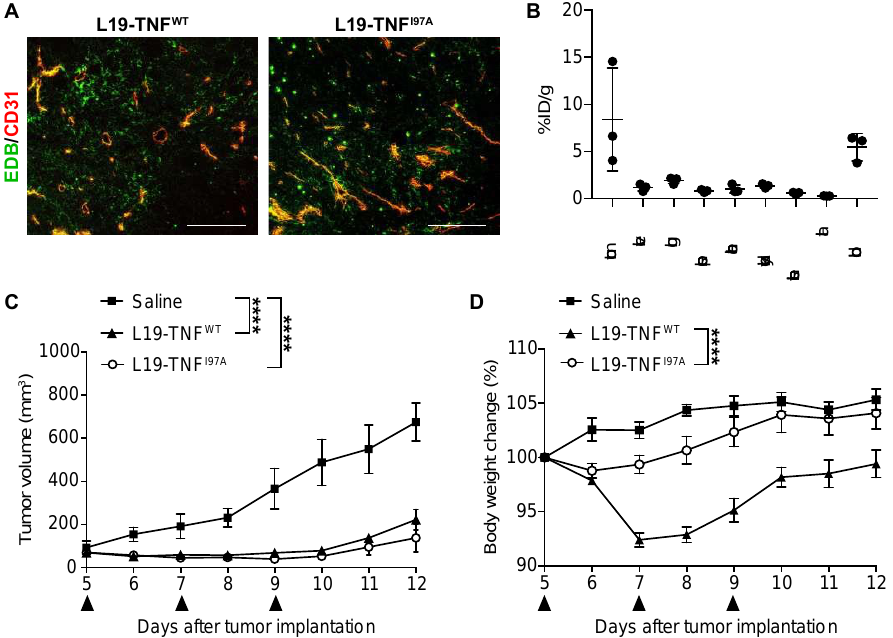
Figure 5. Tumor-targeting performance of L19-TNF I97A and in vivo therapy study in tumor-bearing mice. ( A ) Immunofluorescence staining of WEHI-164 tumors with L19-TNF I97A (L19-TNF WT was used as the positive control of the experiment). Green = L19-TNF WT or L19-TNF I97A , Red = CD31. Scale bar = 100 µm. ( B ) In vivo biodistribution with radioiodinated L19-TNF I97A in BALB/c mice bearing WEHI-164 subcutaneous tumors, 24 h after intravenous administration. The product shows selective accumulation in tumor lesions ( n = 3). Assessment of therapeutic efficacy and toxicity in BALB/c mice bearing WEHI-164 subcutaneous tumors. Mice were injected with a high dose of L19-TNF products (375 µg/kg, black arrows indicate IV administration). Tumor volume ( C ) and changes in animal body weight ( D ) induced by the administered therapeutic proteins were monitored throughout the study (mean ± SEM; n = 3). The statistical analysis for the tumor volume was performed using a two-way ANOVA analyses with Bonferroni post-test **** p < 0.0001).